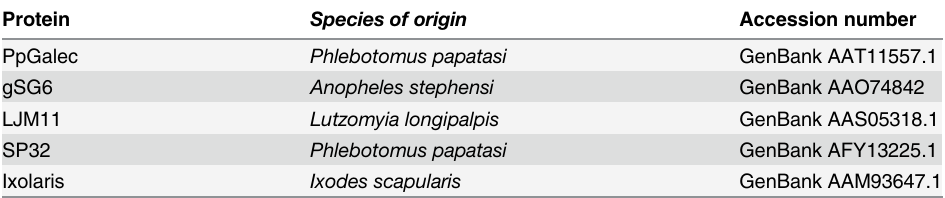
Table 2. Accession/ID numbers of proteins mentioned in the article.